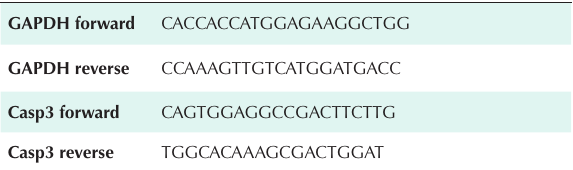
Table 1. Primers Sequences Used in Real-Time Polymerase Chain Reaction GAPDH forward